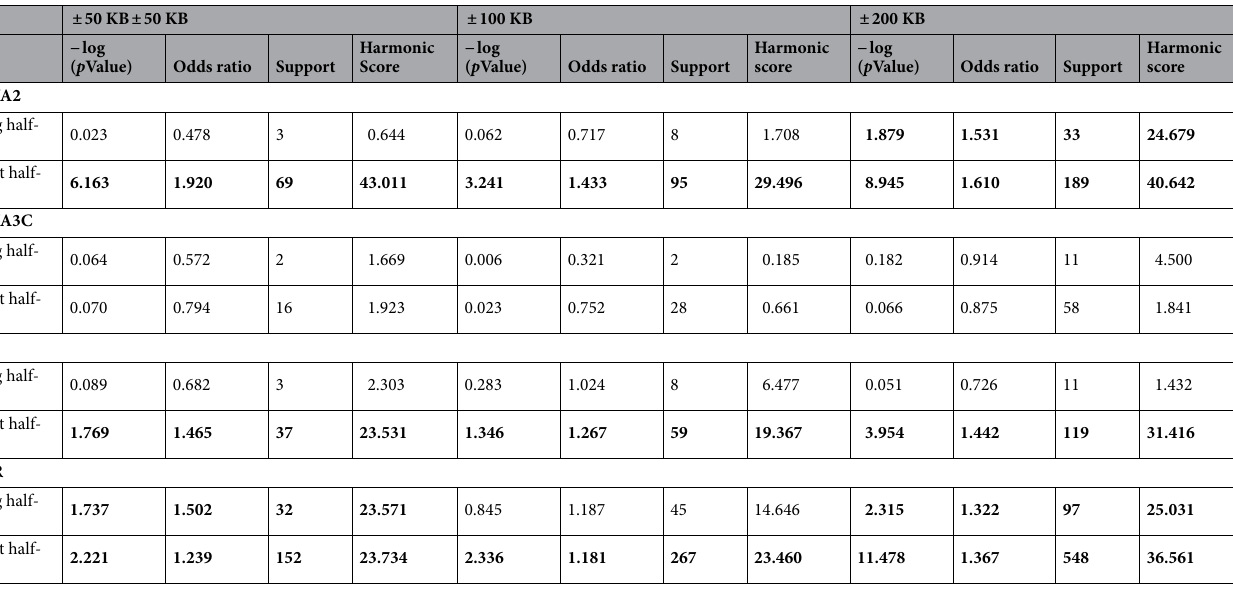
Table 3. Colocalization of human and viral transducer DBRs and MS-GWAS positions (at ± 50,100,200 kb range of extension) in DNA regions coding for transient transcripts; significant results ( p < 0.05,